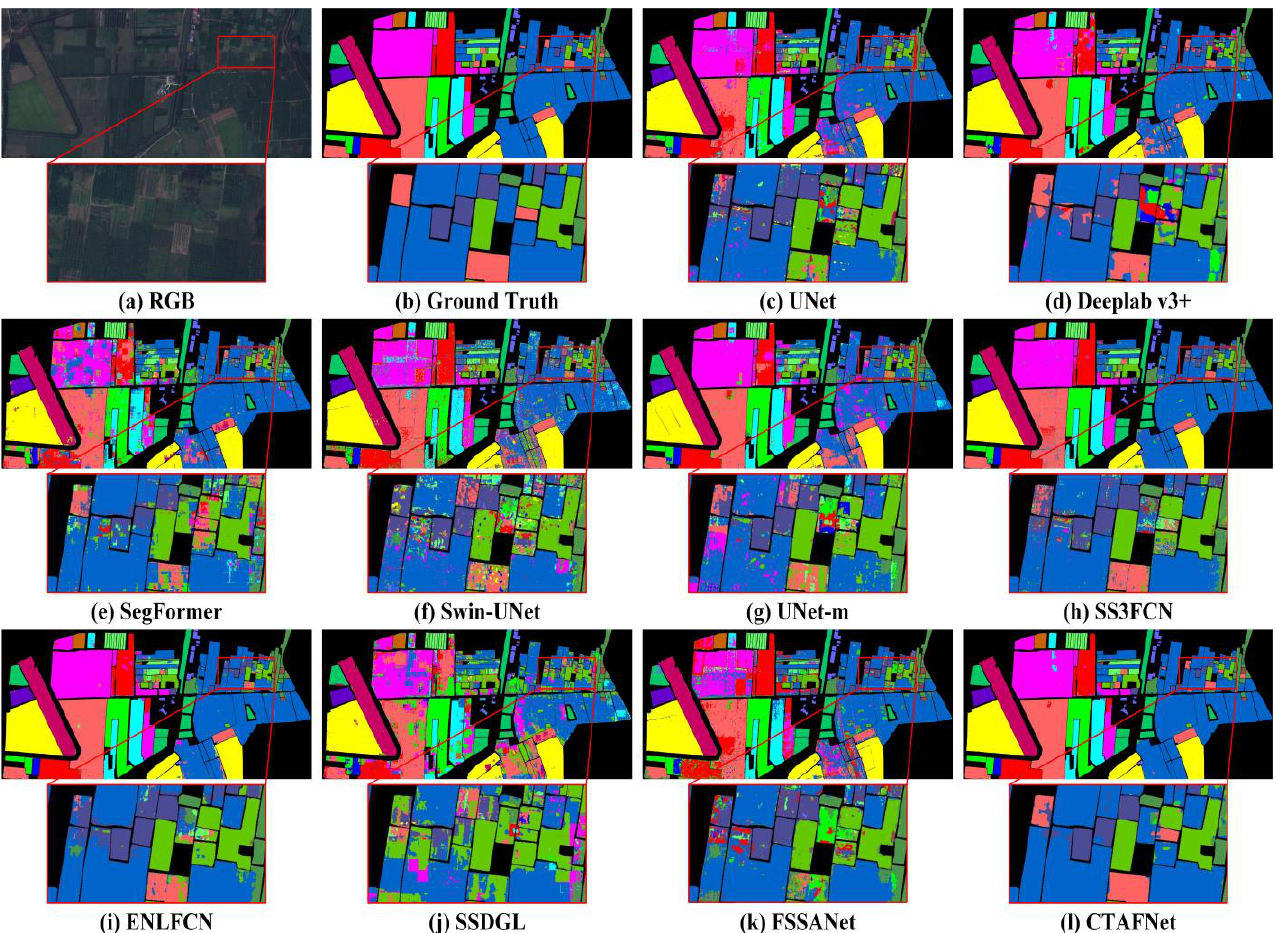
Figure 9. Visually comparison of different methods on the Xiongan dataset. Table 7 shows the experimental results of different methods in the Xiongan test